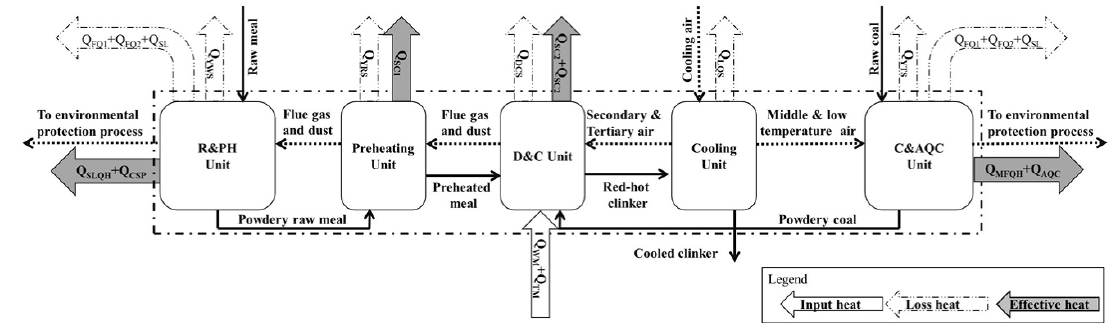
Figure 6. Heat flow modeling of the whole system.